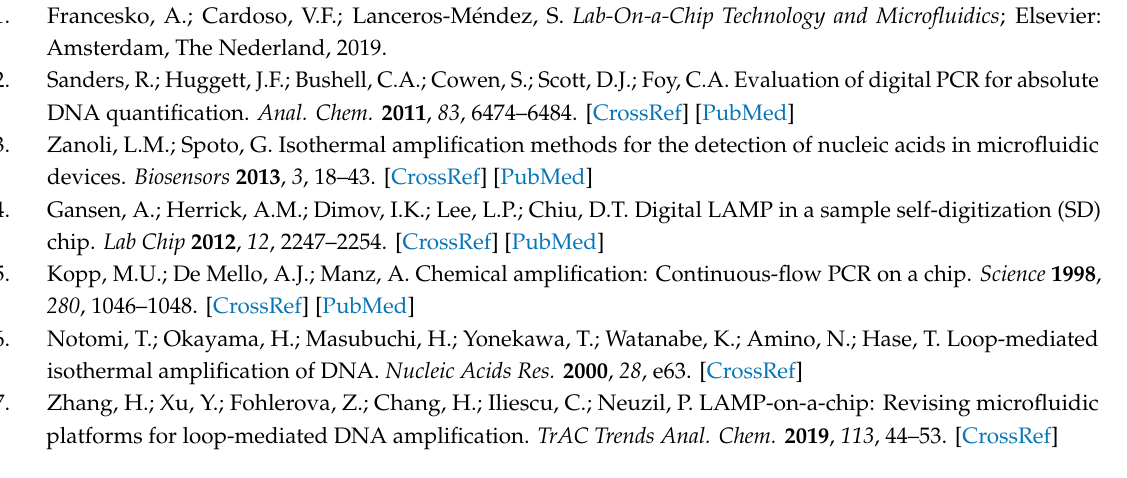
Figure A1: Copy number estimate based on gel electrophoreses, Table B1: List of LAMP primers, Figure C1: E ff ect of laser power in microfluidic channel optimization, Figure C2: E ff ect of single vs. double line in microfluidic channel optimization, Figure D1: Poisson partitioning